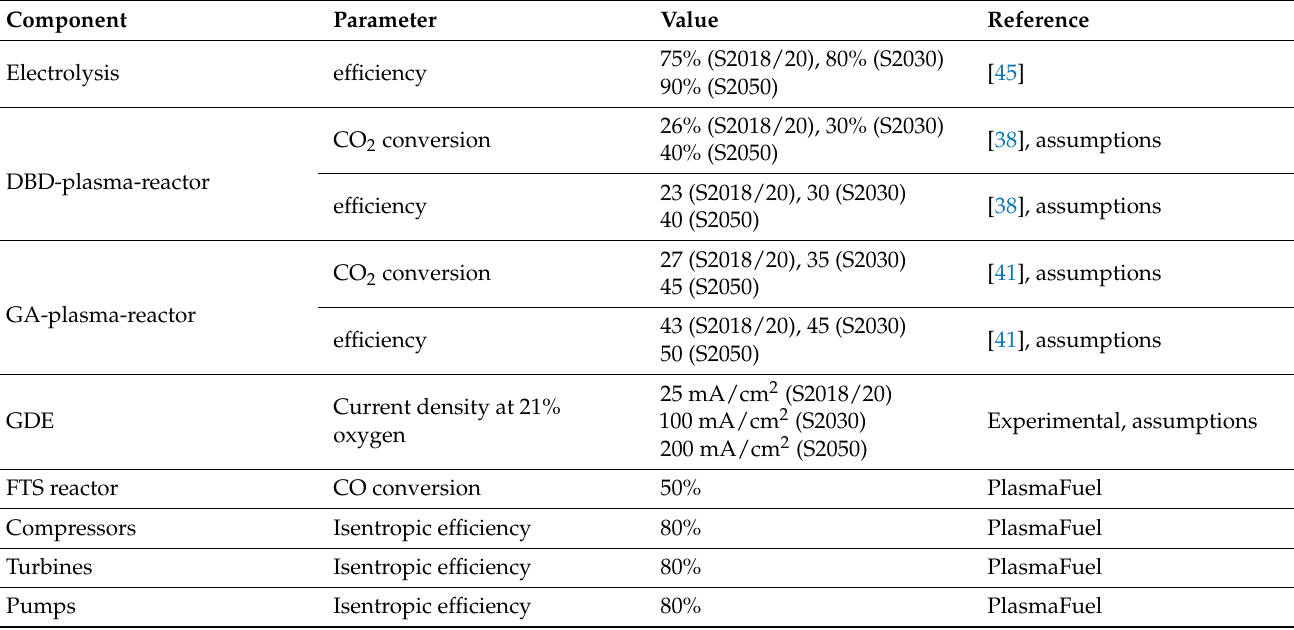
Table 3. Important technical parameters of the modeled